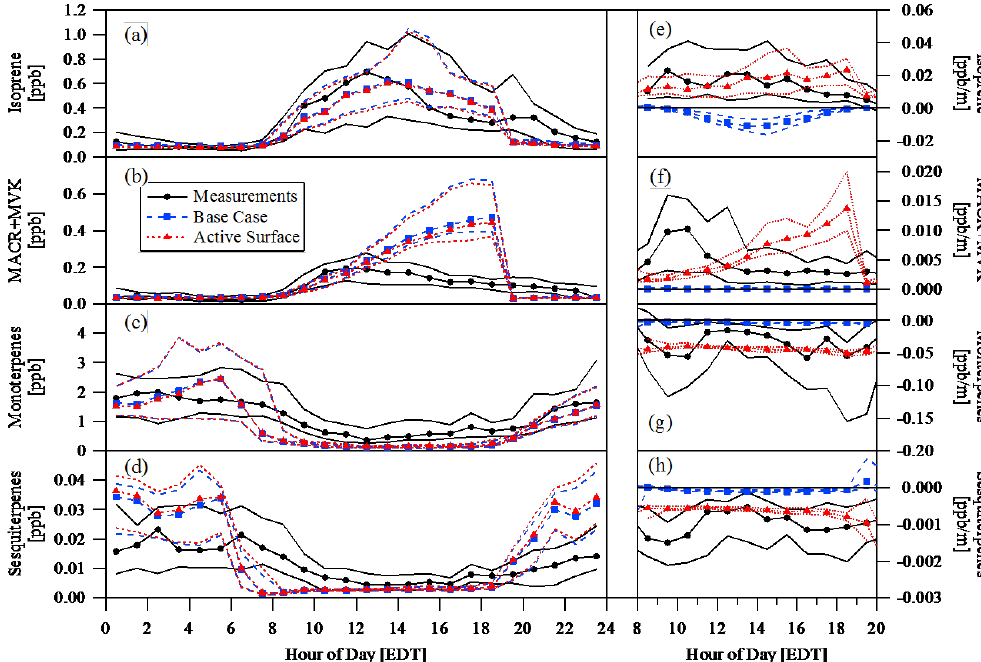
Figure 3. Hourly medians and quartiles of measured and modelled mixing ratios (a–d) and daytime slopes (e–h) . Measurements (black circles), the base model case (blue squares), and the active surface case (red triangles) are compared. Sesquiterpene measured mixing ratios and slopes (d, h) are not calibrated and are presented with units in order to compare to the model output.